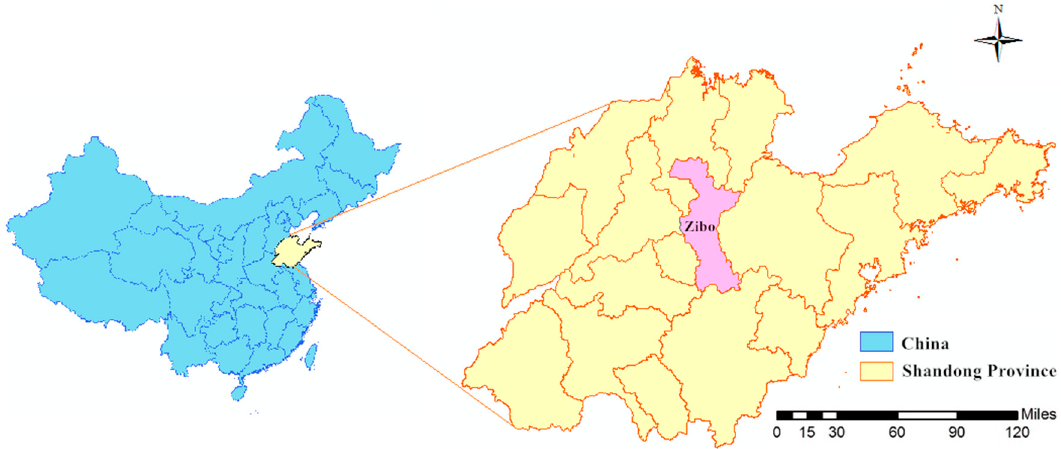
Figure 1. The geolocation of Zibo City in Shandong Province, China (map was created with ArcGIS software, v. 10.2).